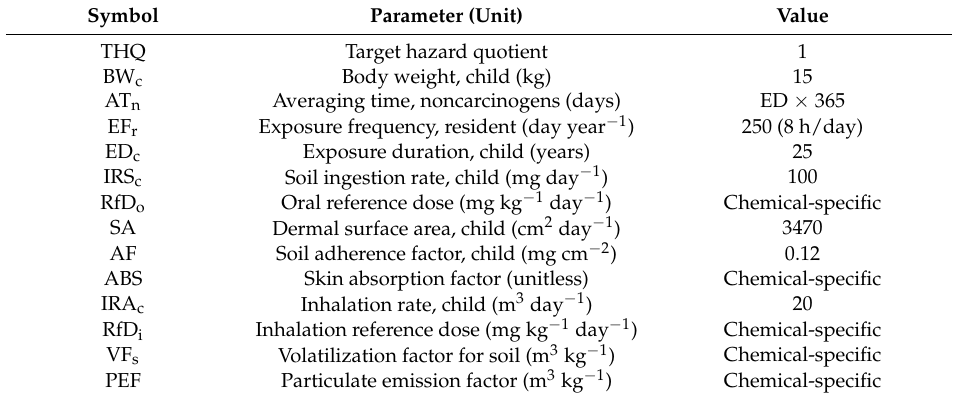
Table 1. Exposure parameters for noncarcinogenic risk